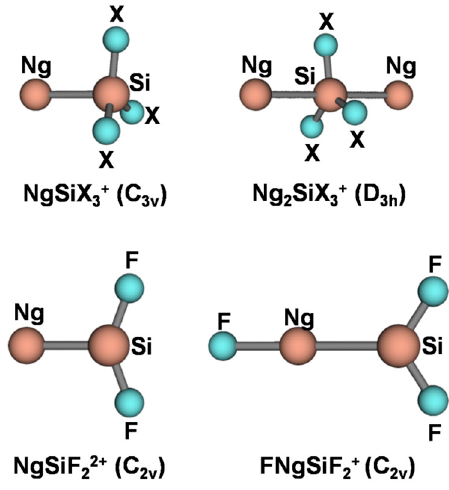
Figure 1. Connectivities and point groups of the Ng-Si cations. Table 3. MP2/aVTZ type and properties of the Ng-Si bonds of the Ng-Si cations. R (Å) is the bond distance; D e is the electronic dissociation energy (kcal mol − 1 ); Ω s is the volume ( a 03 ) enclosed by the s ( r ) = 0.3 RDG isosurface at around the BCP; and N ( Ω s ), ρ s (ave), H s (ave/max/min) and BD s (ave) are, respectively, the total electronic charge (m e ), the average electron density ( e a 0 − 3 ), the average, maximum and minimum value of H ( r ) (hartree a 0 − 3 ), and the average BD (hartree e − 1 ) over Ω s .